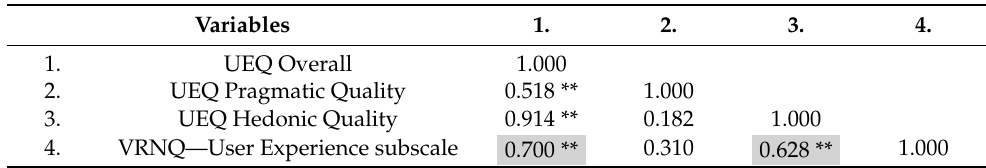
Table 13. Correlation matrix for LA_NORF condition—Spearman ( ρ ) correlation coefficients for combined user experience measures ( n = 4).